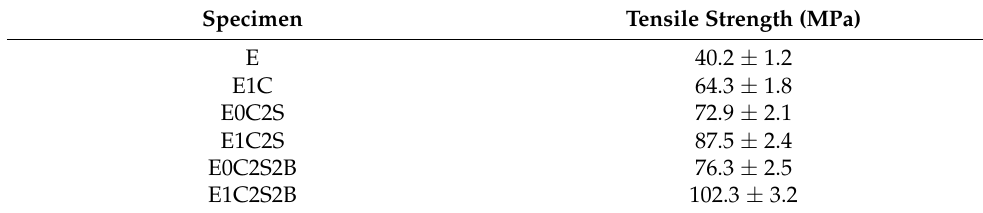
Figure 2. Epoxy and epoxy multiscale composites. Table 3. Tensile properties of epoxy and multiscale composites.